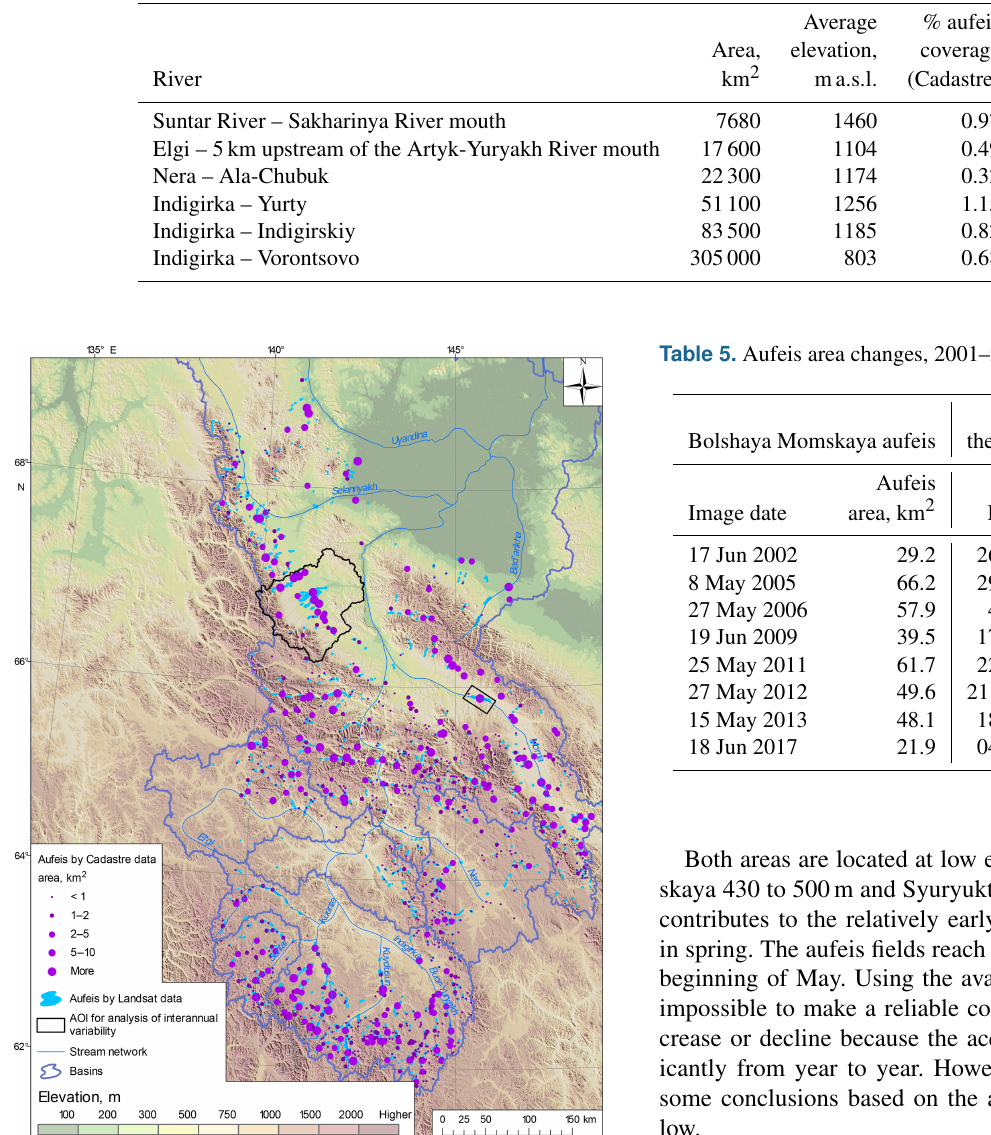
Table 4. Aufeis area coverage (percentage) in the sub-basins within the Indigirka River watershed by the Cadastre and Landsat data.